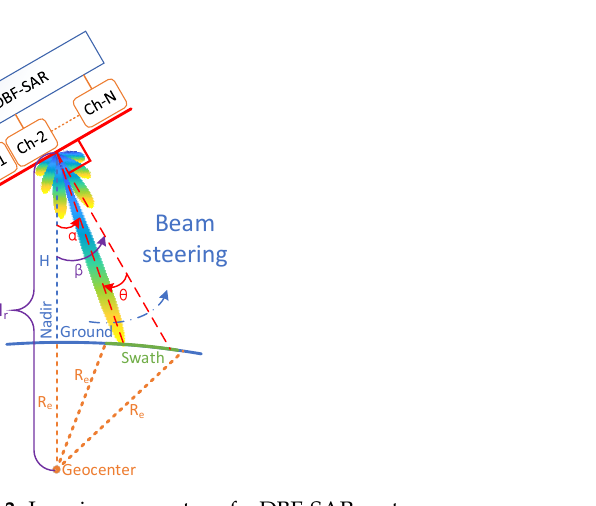
Figure 3. Imaging geometry of a DBF-SAR system.